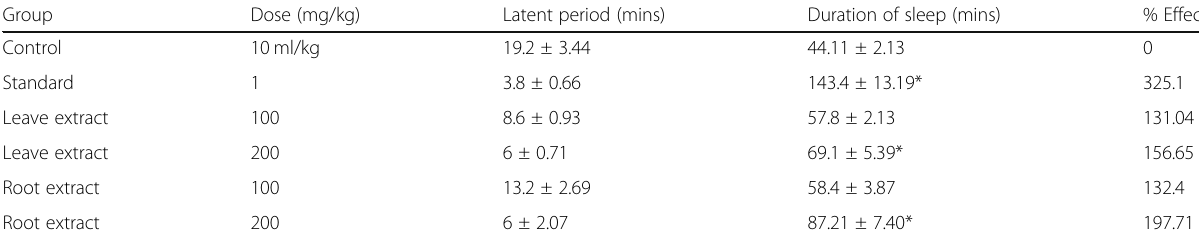
Table 1 Effect of C. turgida extracts on thiopental-Na induced sleeping time on mice